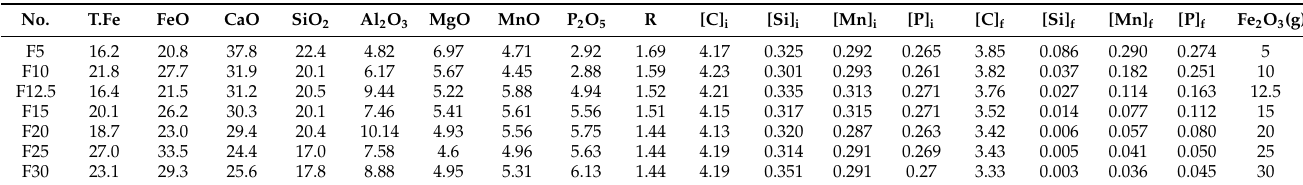
Table 3. Compositions of the slag and hot metal after dephosphorization as well as the compositions of initial hot metal (mass%). No.